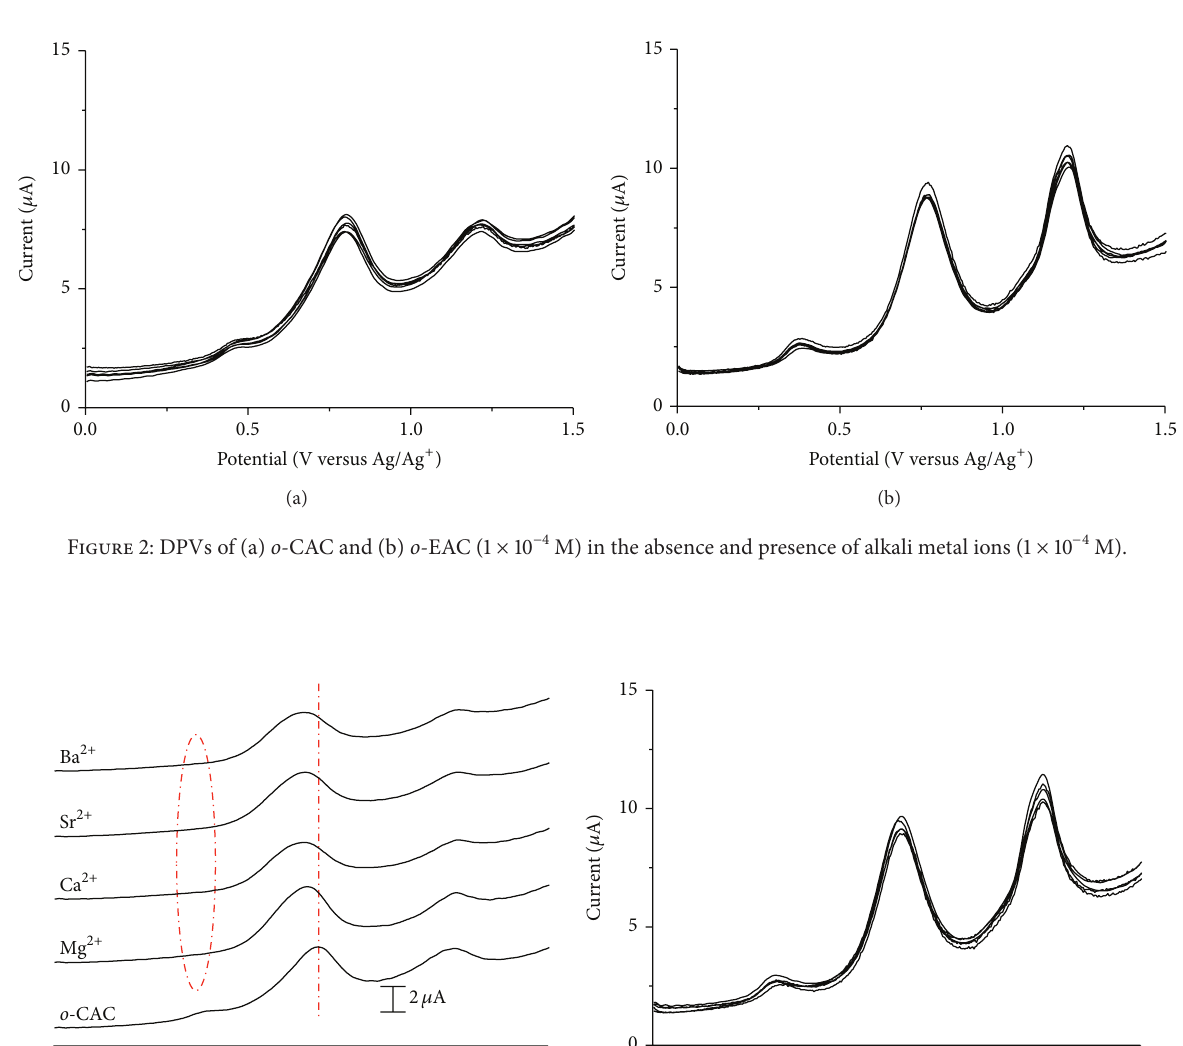
adding stoichiometric equivalent of metal ions successively to the respective electrochemical solution. DPVs of 0.1 mM o - CAC and o -EAC in the presence of one equivalent of alkali and alkaline earth metal ions are shown in Figures